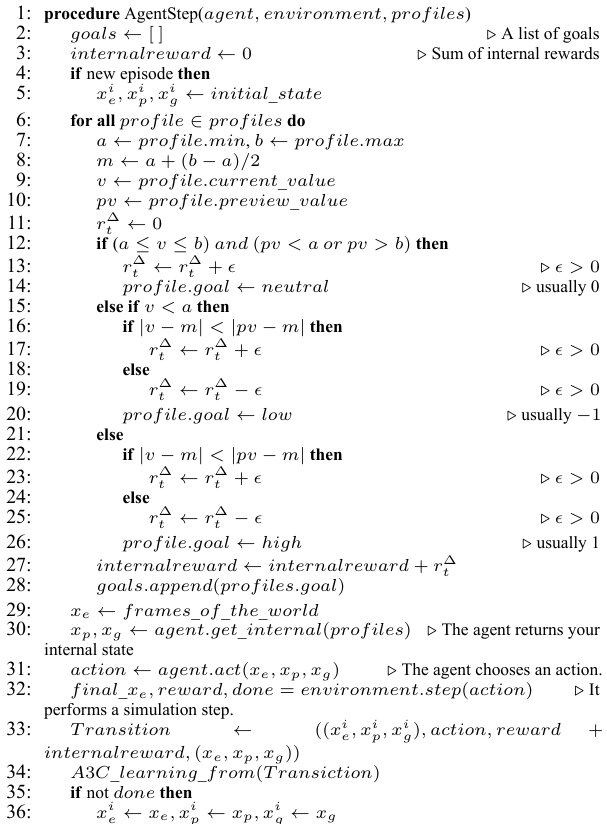
Algorithm 1 Agent-based on Explicit Goals (A3CEG). Agent, environment, and profiles are objects that encapsulate agent, environment, and agent’s profile.